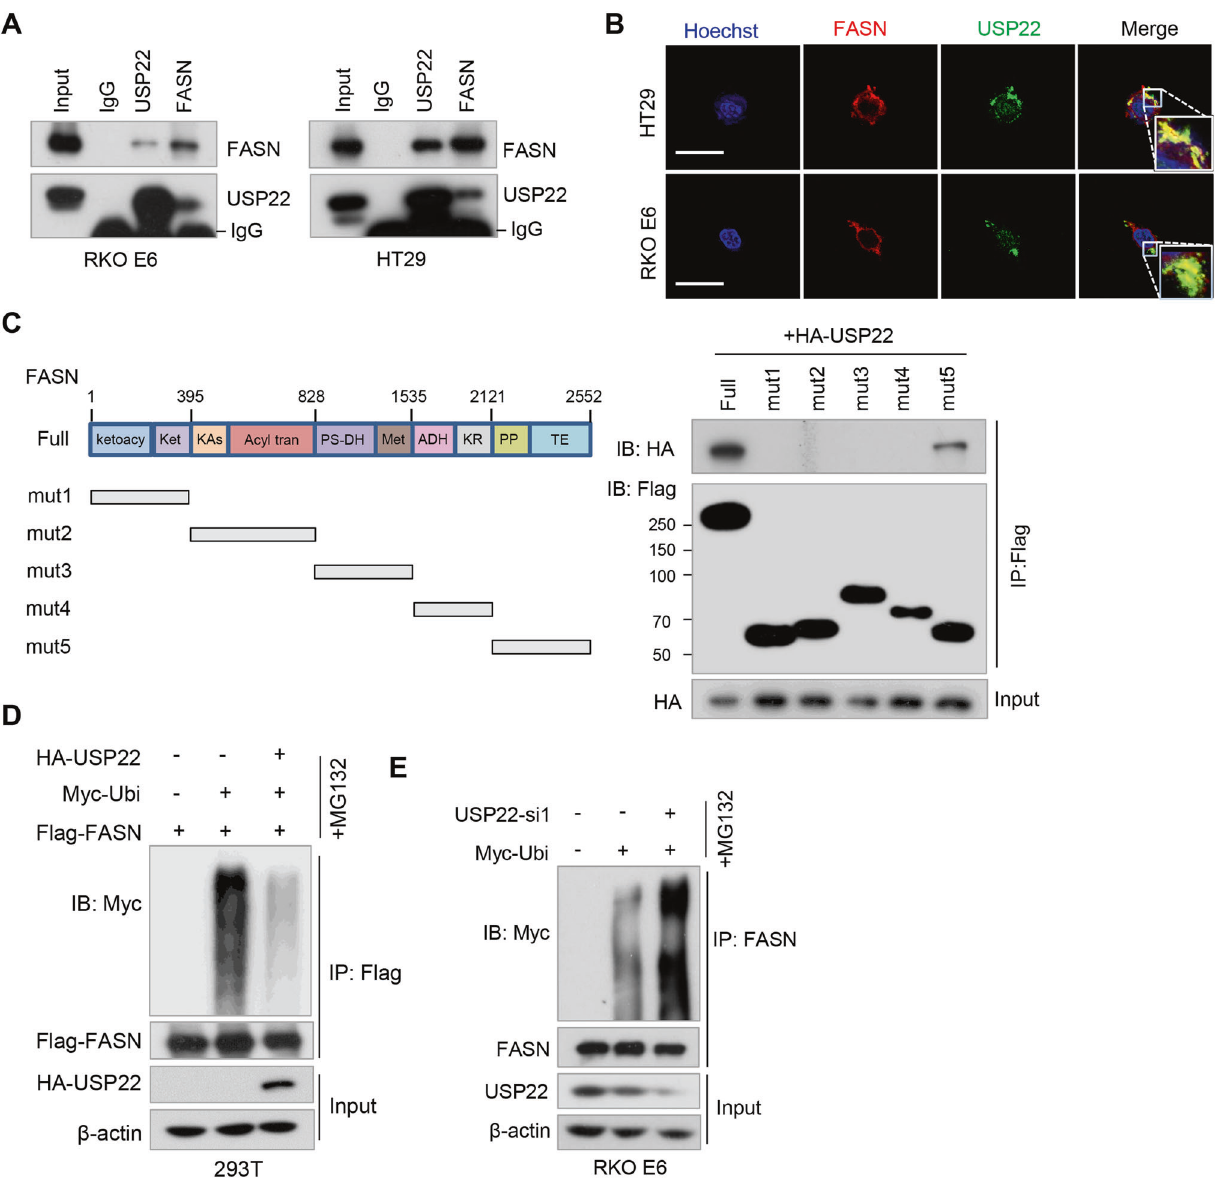
Fig. 2 USP22 interacts with FASN and inhibits FASN ubiqutination. A RKO E6 and HT29 cell lysates were immunoprecipitated using antibodies against USP22 and FASN, and then subjected to immunoblotting. IgG was used as an isotype control. B Immuno fl uorescence assays were performed in RKO E6 and HT29 cells using antibodies against USP22 and FASN. Scale bar, 20 μ M. Insets: high-magni fi cation images. C A series of Flag-tagged FASN deletion mutants were constructed and co-transfected with HA-USP22 into 293T cells. Cell lysates were immunoprecipitated using an anti-Flag antibody and then analyzed by immunoblotting. The domains of FASN protein are indicated (left panel). D 293T cells were transfected with Flag-FASN, Myc-Ubi, and HA-USP22, and then treated with MG132 for 6 h. Cell lysates were immunoprecipitated using an anti-Flag antibody and then analyzed by immunoblotting. E RKO E6 cells were transfected with USP22 siRNA and Myc-Ubi, and then treated with MG132 for 6 h. Cell lysates were immunoprecipitated using an anti-FASN antibody and then analyzed by